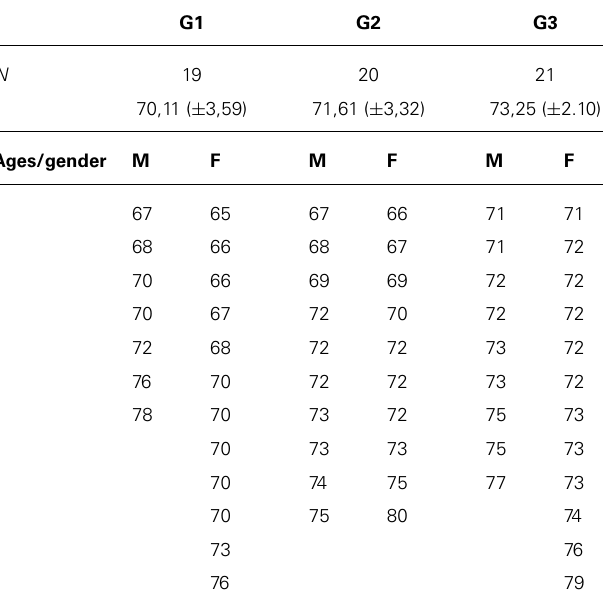
Table 1 | Distribution by age and gender of three